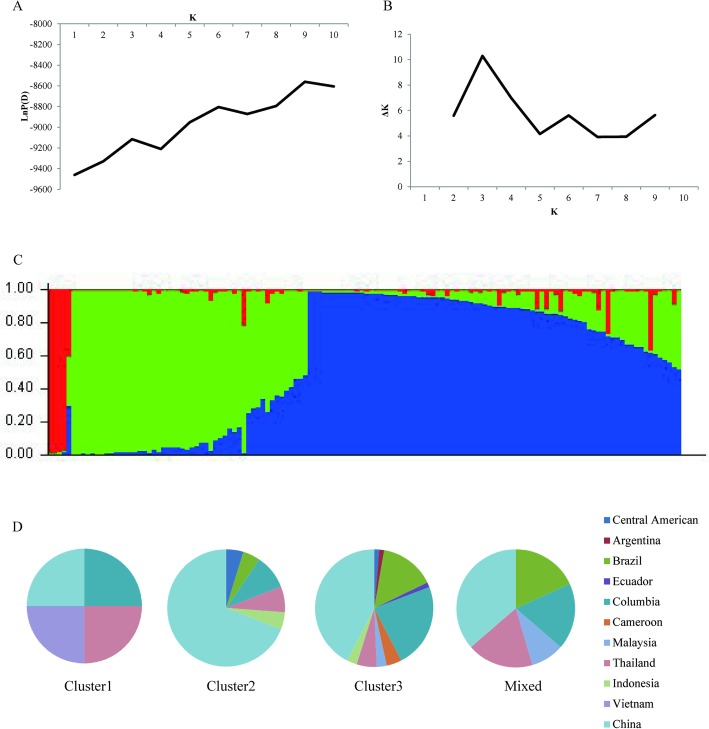
Population structure analysis.A, LnP(D) value graphed against K from 1 to 10. B, ΔK values at K from 1 to 10. C, stacked column chart of Q matrix. D, Origin distributions of the three clusters and mixed cluster.